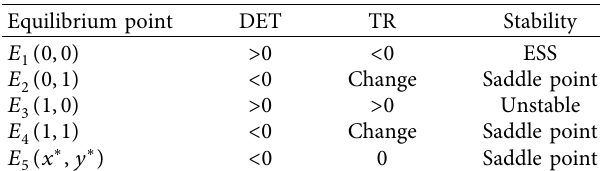
Table 7: Stability analysis of strategy system ( e ) of the government and